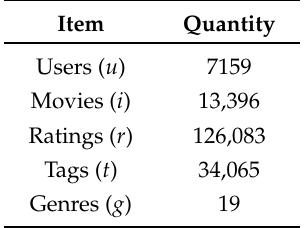
Table 2. A summary of the used